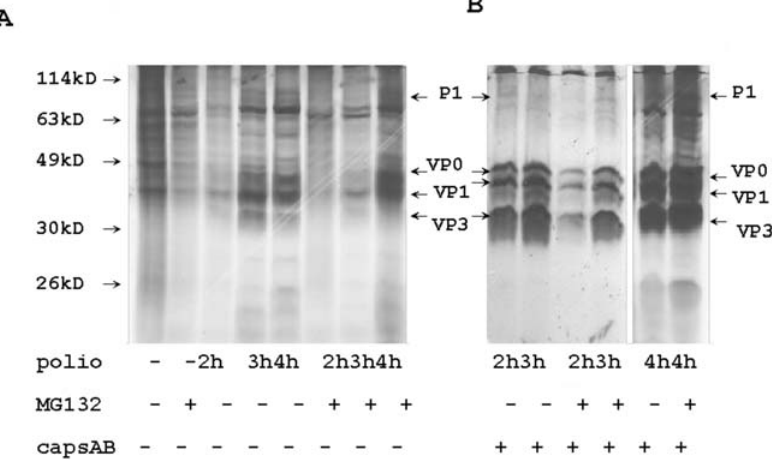
Figure 7. Poliovirus protein synthesis was delayed in MG132-pretreated cells. Control HeLa cells and HeLa cells pre-treated with MG132 for 2 h were infected with poliovirus (MOI=5) for 2, 3 and 4 h. All cells were incubated in methionine/cysteine free medium supplemented with S 35 - methionine/cysteine for last 30 min before harvesting. To study general translation, 10 m g of cytoplasmic protein extracts were separated by electrophoresis and analyzed by autoradiography (A). To study poliovirus capsid protein accumulation, capsid proteins were precipitated by specific Abs from 100 m g of cytoplasmic protein extracts and analyzed by electrophoresis and autoradiography (B).